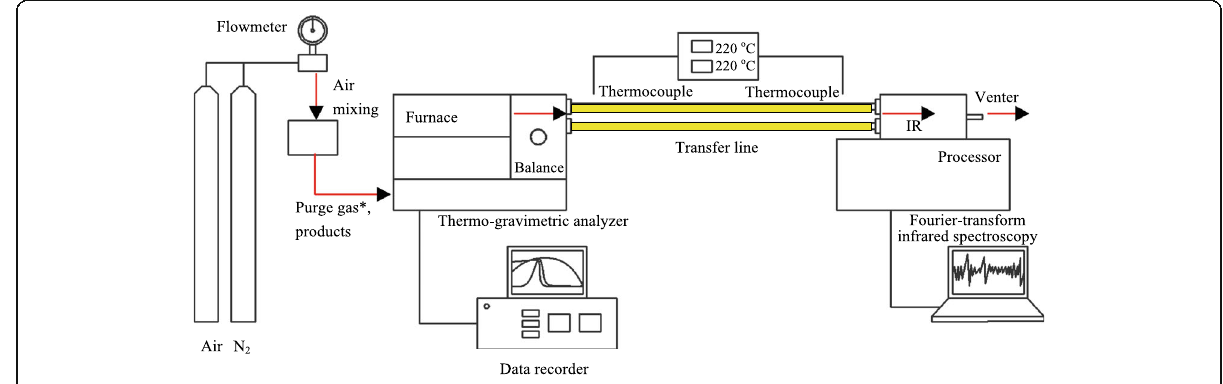
Fig. 1 Schematic diagram of TGA-FTIR